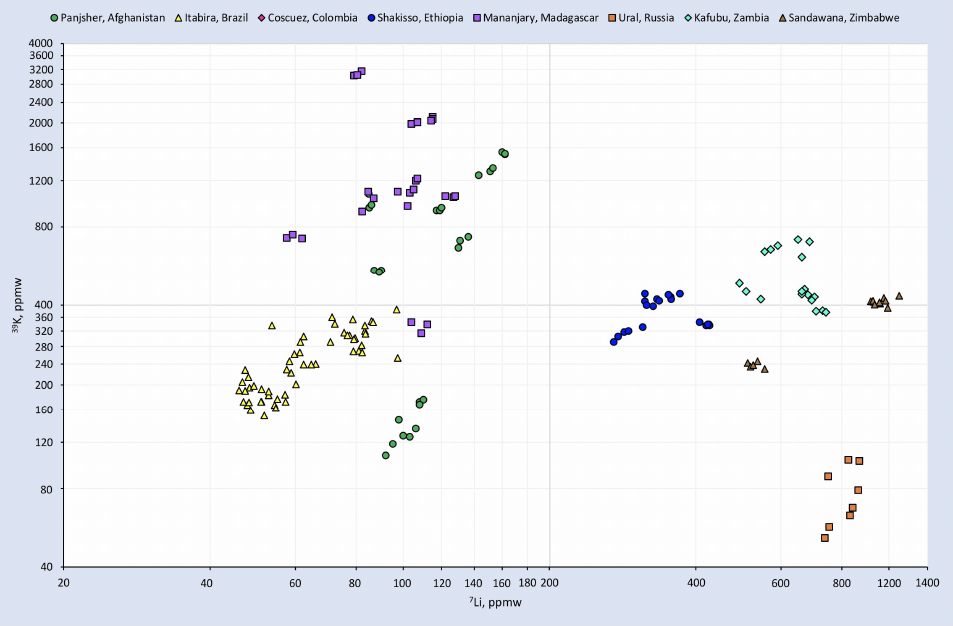
Figure 3. Binary plot of 7 Li vs. 39 K.